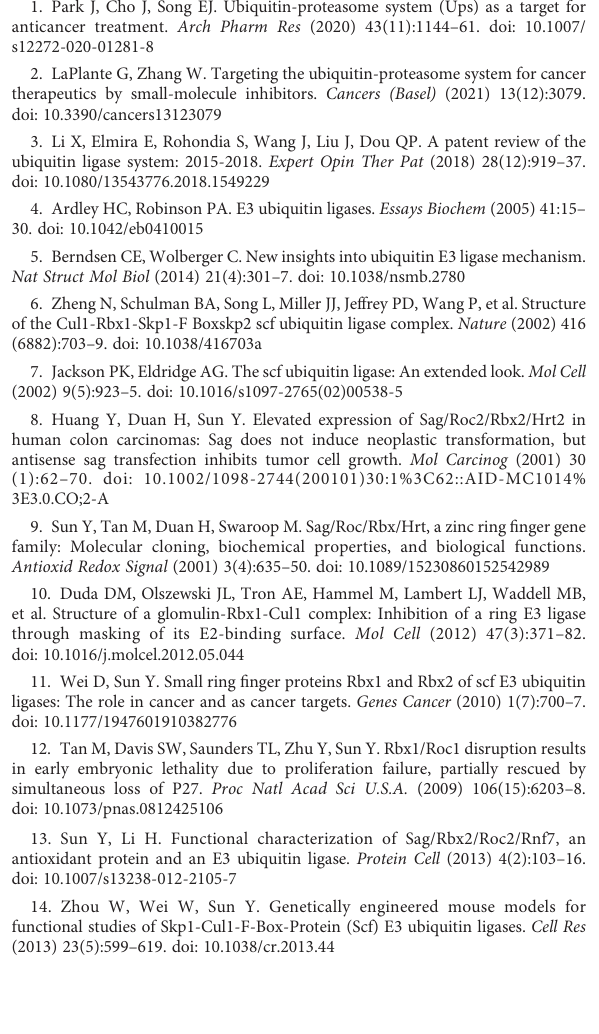
SUPPLEMENTARY TABLE 1 The summarization of alterations of RBX1 and RBX2in all typesof cancers. These statistical data are mainly from online databases and R package